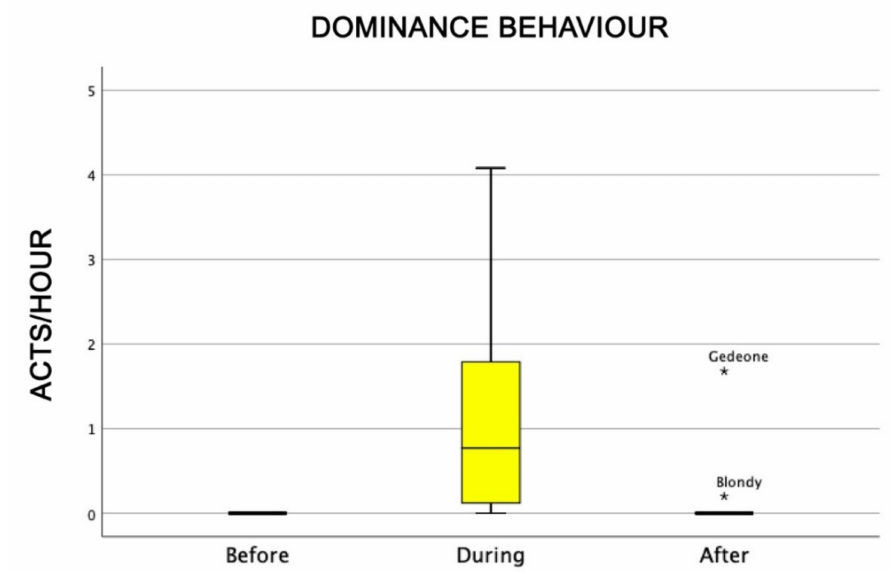
Figure 2. Behavioural patterns related to dogs’ dominance behaviour before, during, and after AAI sessions. Non-parametric data are represented as medians (horizontal bar in the box) and the box indicates the interquartile range of 50% of the data. Whiskers extend to the smallest and largest values and exclude outliers (dot on